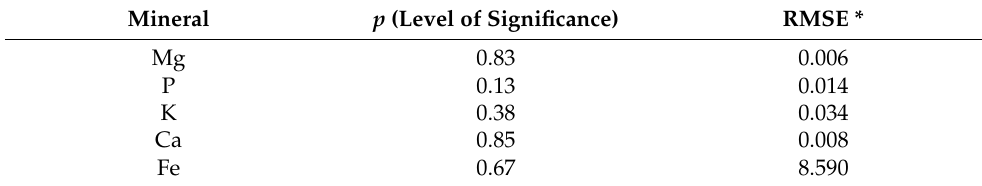
Table 5. External validation for the NIR determination of minerals in fortified flours. Mineral p (Level of Significance) RMSE * Mg 0.83 0.006 P 0.13 0.014 K 0.38 0.034 Ca 0.85 0.008 Fe 0.67